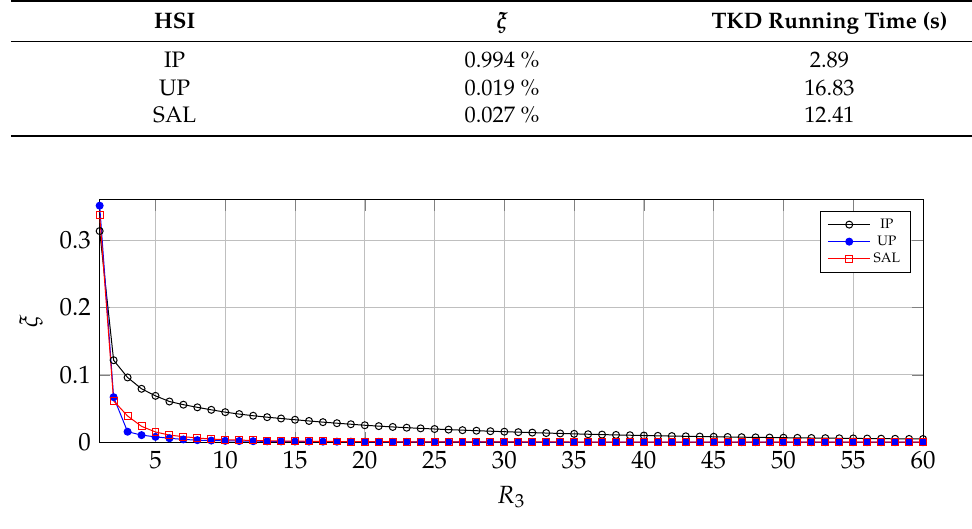
Figure 8. Relative error between original data and the reconstruction from core